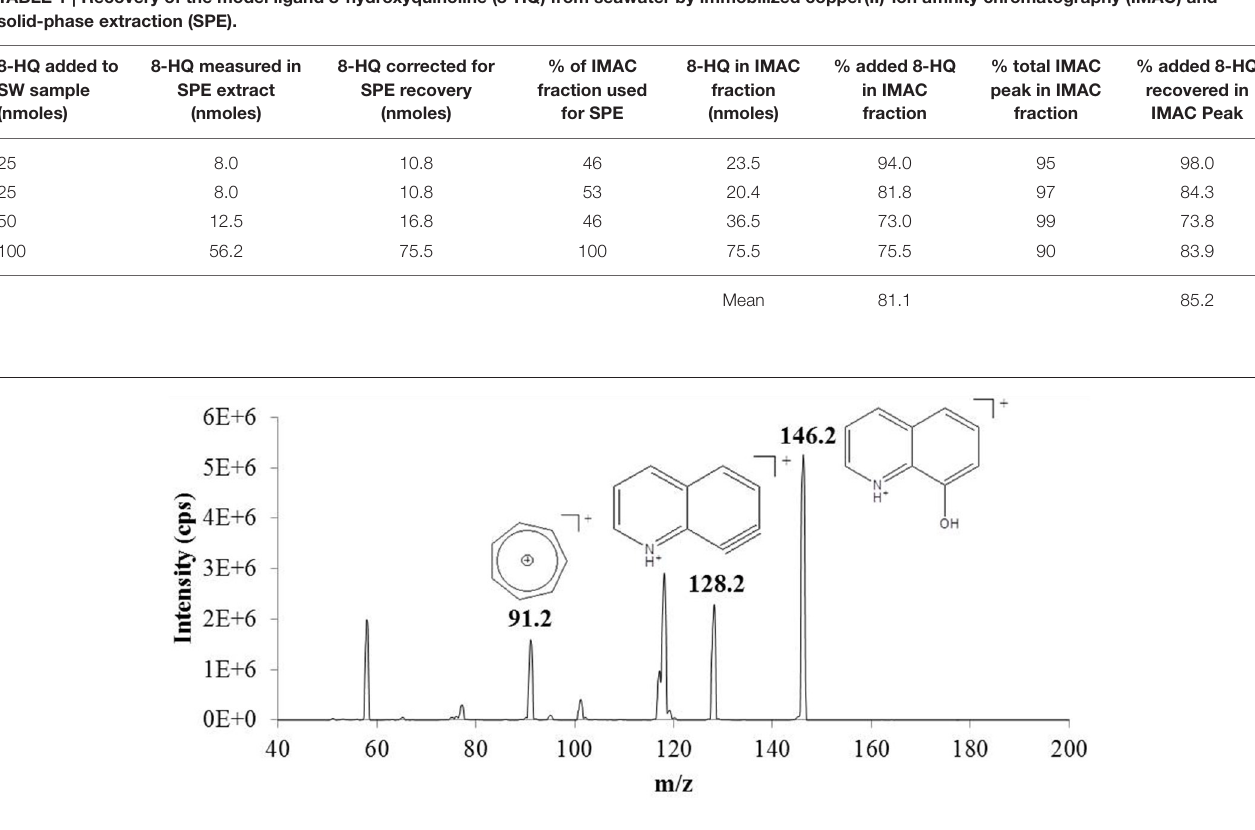
FIGURE 2 | Product-ion mass spectrum of the protonated molecular/precursor ion ( m/z 146.2) of 8-hydroxyquinoline (8-HQ) obtained by electrospray ionization-tandem mass spectrometry (ESI-MS/MS). Precursor-to-product ion transitions corresponding to loss of water ( m/z 146.2 > 128.2) and formation of the stable tropylium ion ( m/z 146.2 > 91.2) were selected for multiple reaction monitoring (MRM) to provide accurate quantification and unambiguous identification of 8-HQ in methanol extracts obtained by solid phase extraction (SPE) (see text).